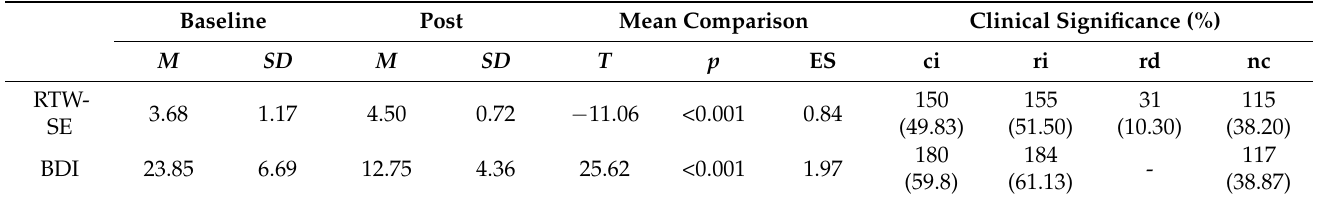
Table 6. Means, standard deviations, effect sizes, and clinical significance before and after outpatient